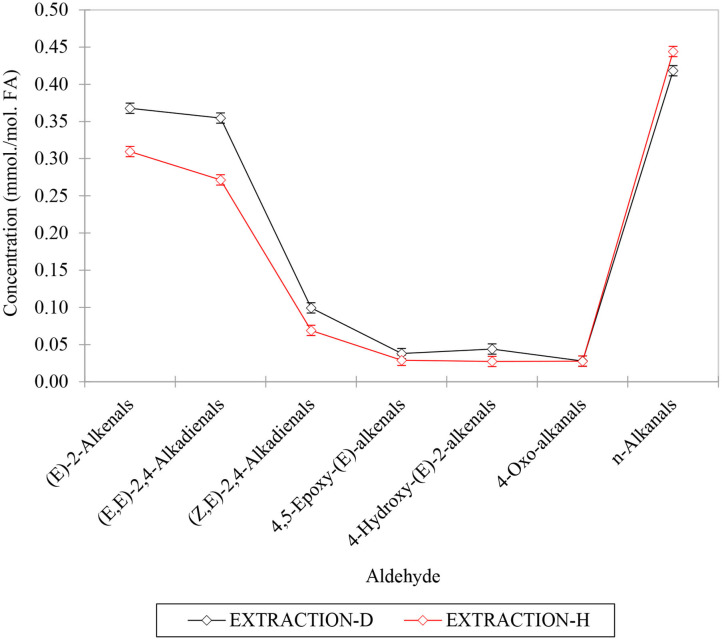
Plot of mean aldehyde concentrations determined using the direct C2HCl3 and exhaustive hexane extraction techniques (designated as EXTRACTION-D and –H, respectively). The differential responses of aldehydes to these extractions are responsible for the highly significant first-order aldehyde x extraction technique source of variation observed for the model 2 ANOVA performed.